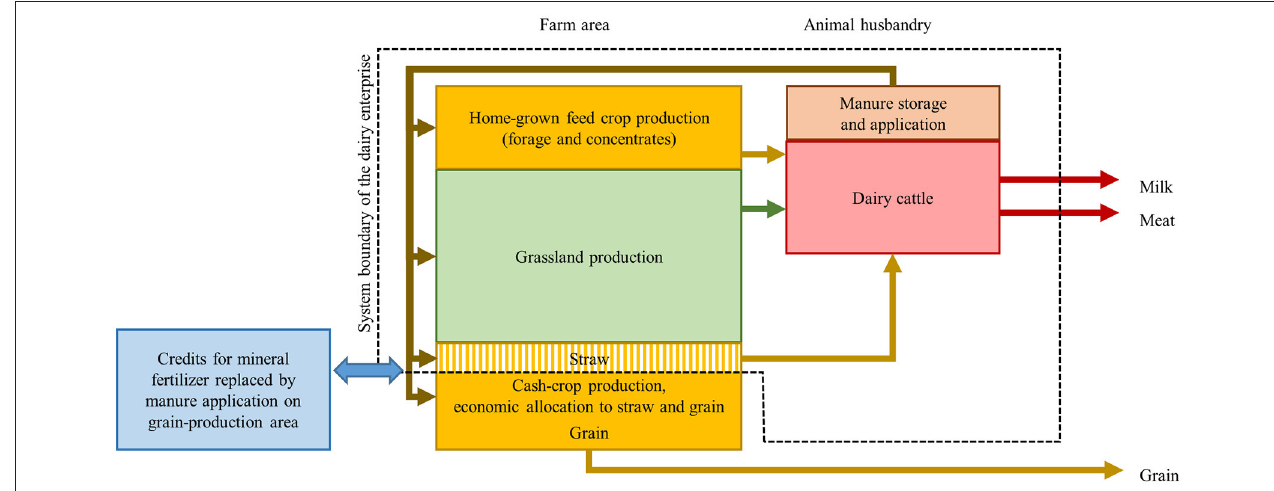
FIGURE 2 | System boundaries of the dairy enterprise. Upstream processes and infrastructure are not illustrated.